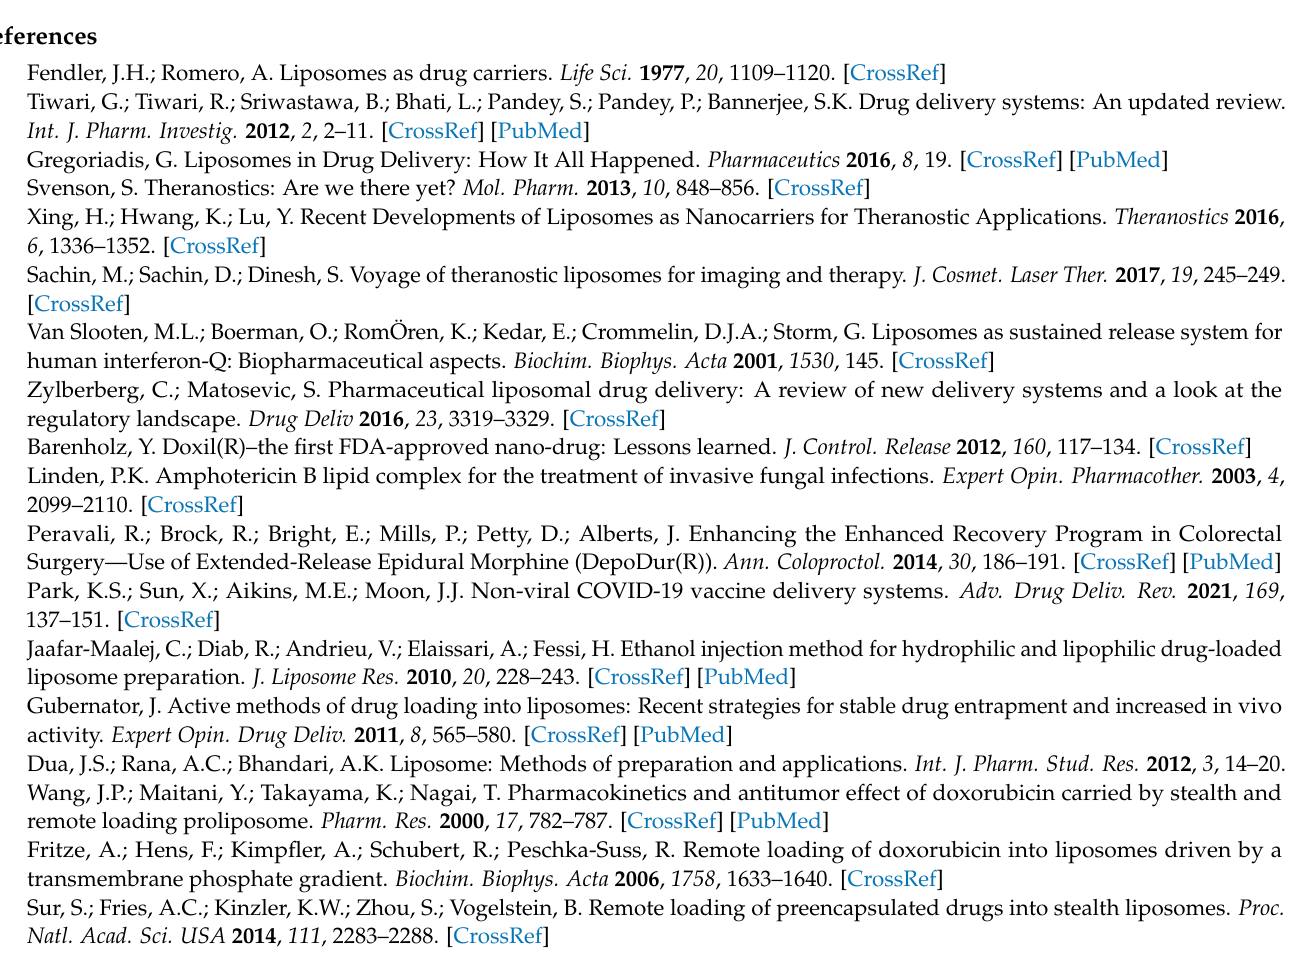
serum on liposome stability; Figure S5: Conjugation efficiency by Ellman’s test; Figure S6: Lipid conformational energy and hydrogen bonds between DSPC and DXR as a function of temperature; Figure S7: Long-range VdW interactions between DXR and Cholesterol; Figure S8: Solvent Accessible Surface Area (SASA) of